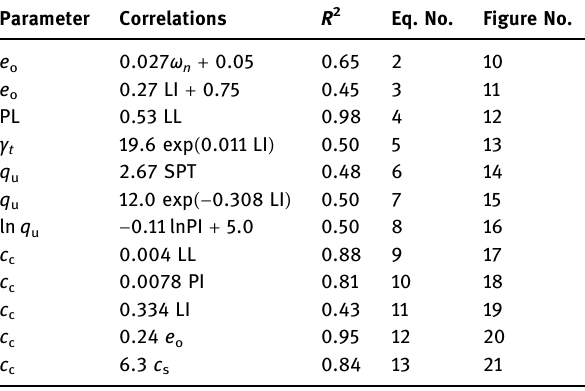
Table 3: Correlations between physical and mechanical properties of clayey soil